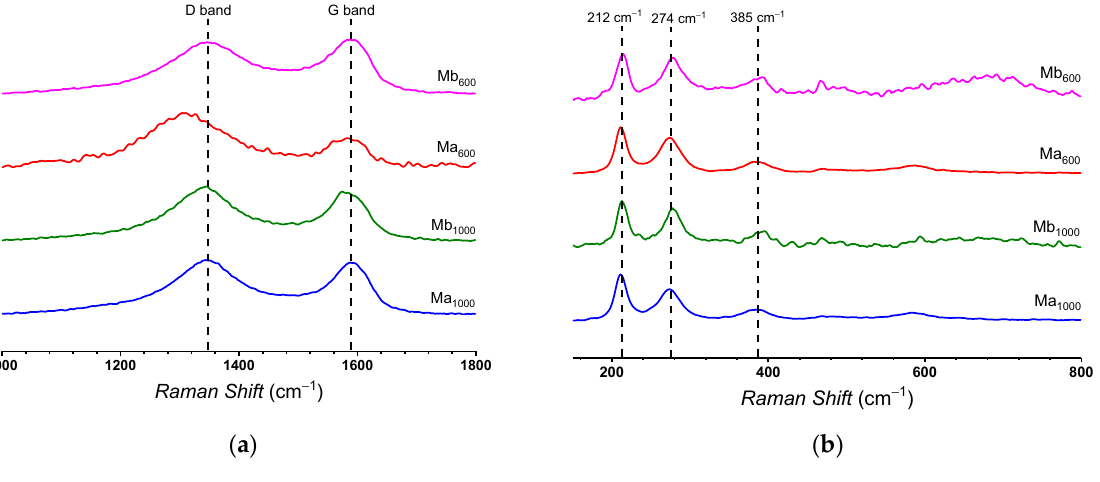
Figure 2. Raman spectra of TrGO: ( a ) and ( b ) TrGO/Fe 3 O 4 .